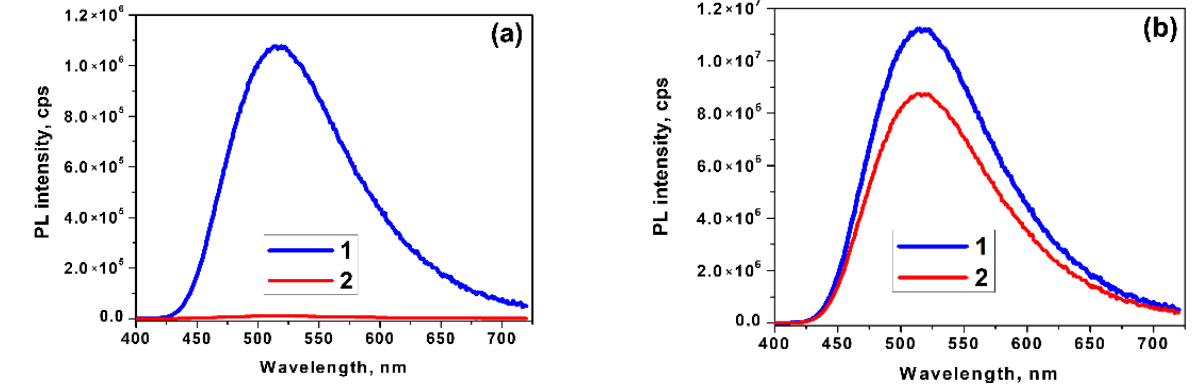
Figure 18. PL spectra of BoronLightSil samples synthesized using ( a ) hydrophilic and ( b ) hydrophobic aerogels: 1—samples immediately after synthesis; 2—after exposure to air for 6 months.